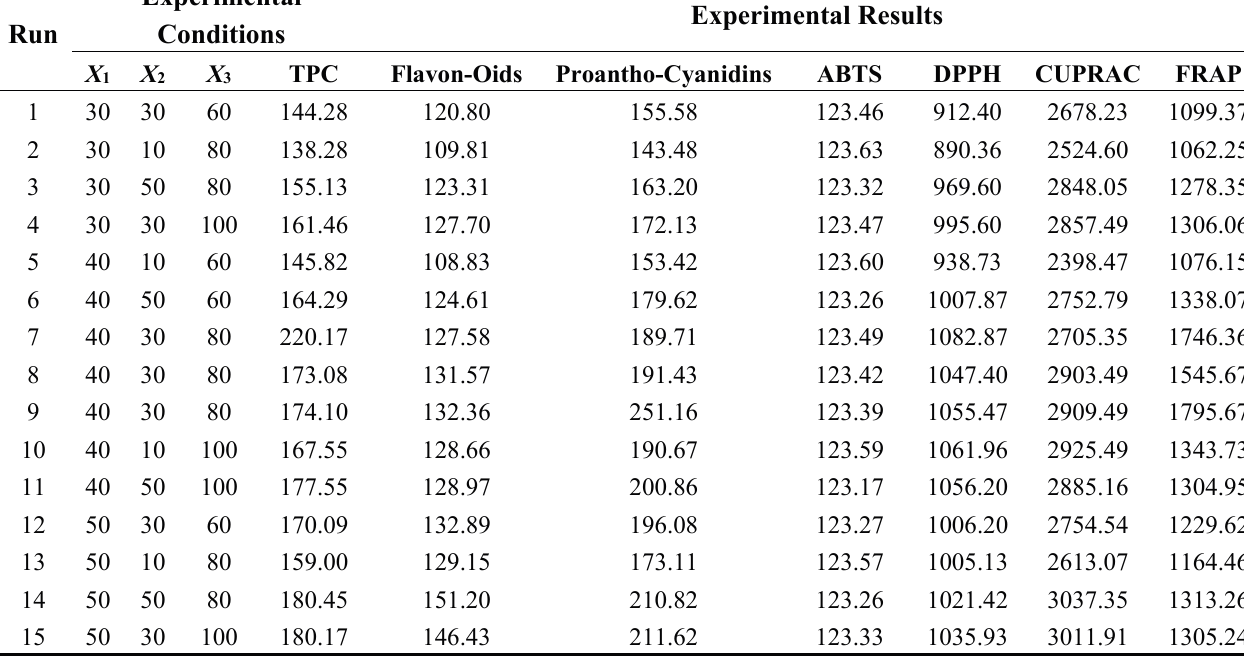
Table 1. Box-Behnken design and the observed